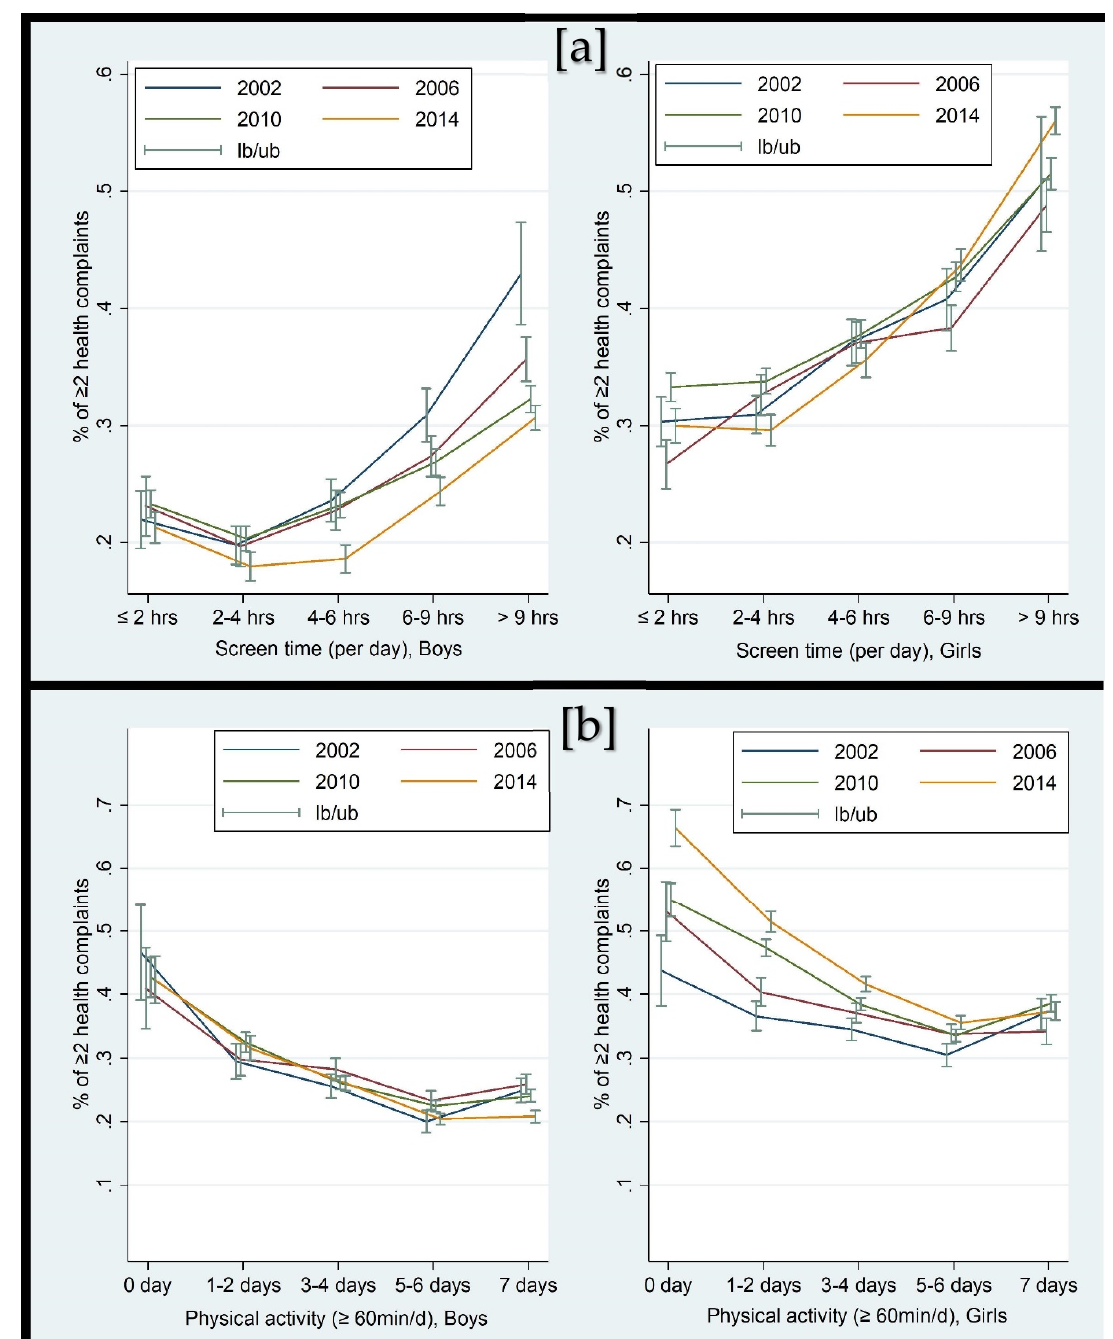
Figure 1. Percent distribution of frequent psychosomatic complaints across different levels of ( a ) screen time and ( b ) physical activity by gender, Canadian HBSC 2002–2014. Note: lb represents lower bound; ub represents upper bound.